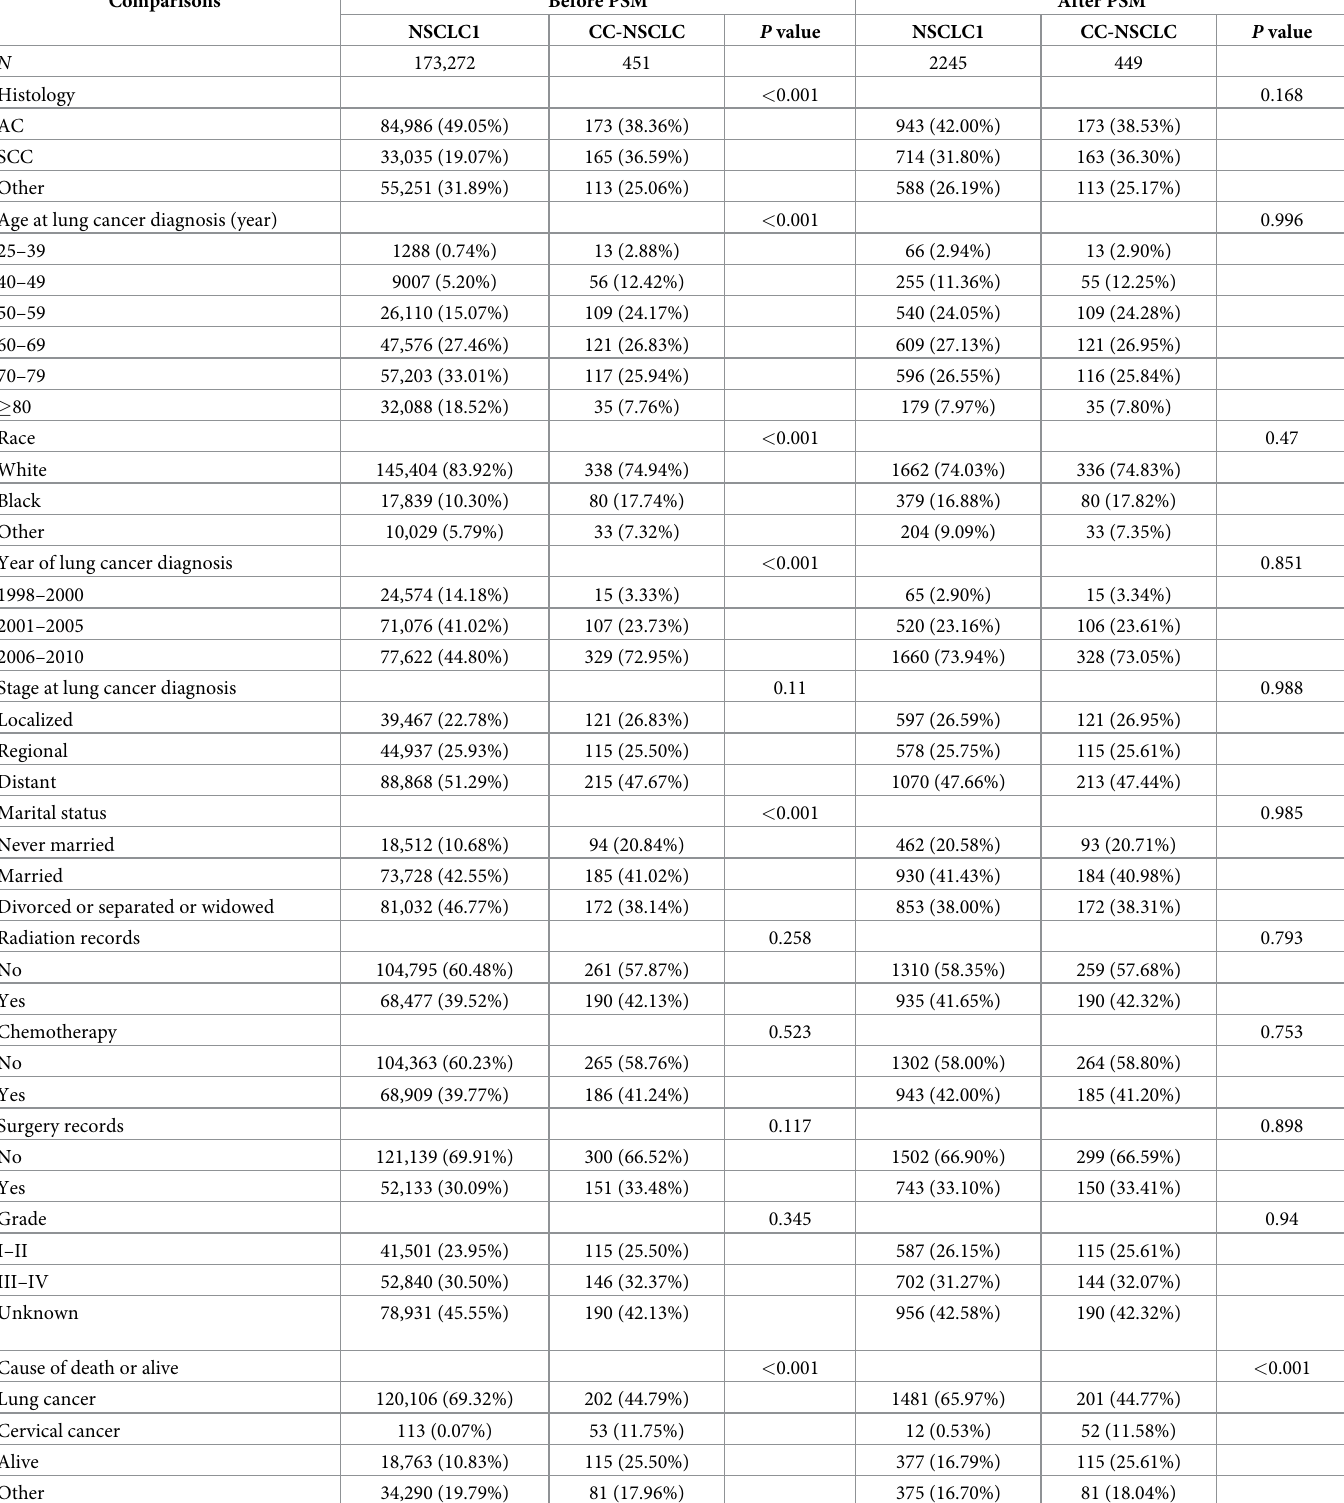
Table 1. Demographic and clinicopathological characteristics of patients with CC-NSCLC and NSCLC before and after PSM.